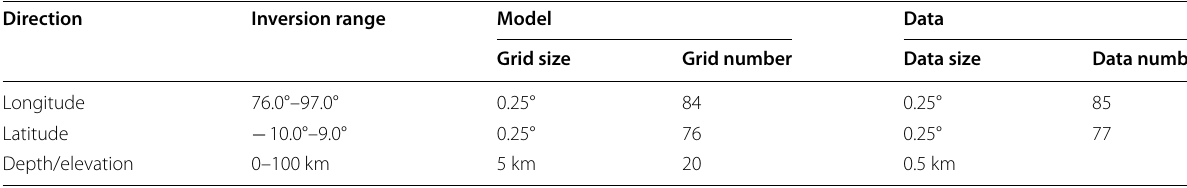
Table 2 3D mesh and datasets for the inversion of Mare Smythii